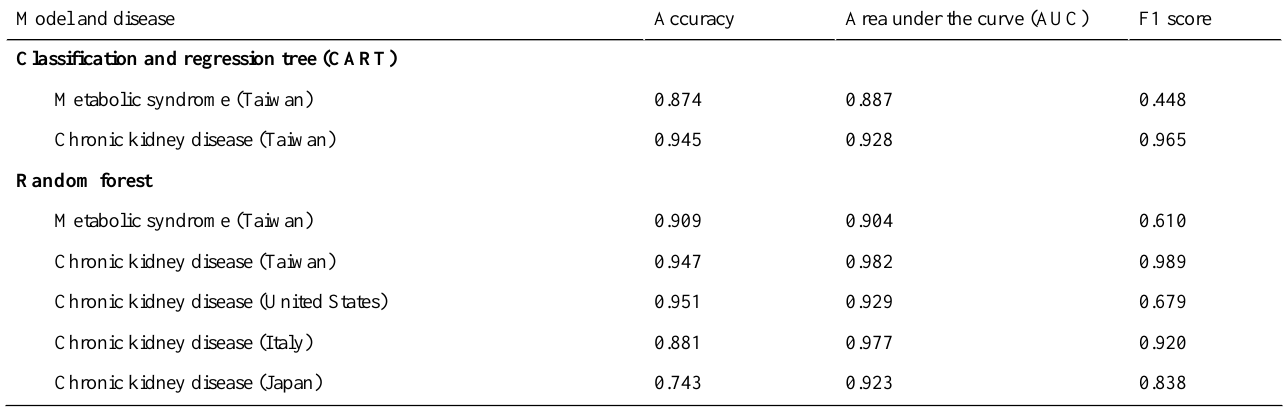
F1 scoreArea under the curve (AUC)AccuracyModel and disease